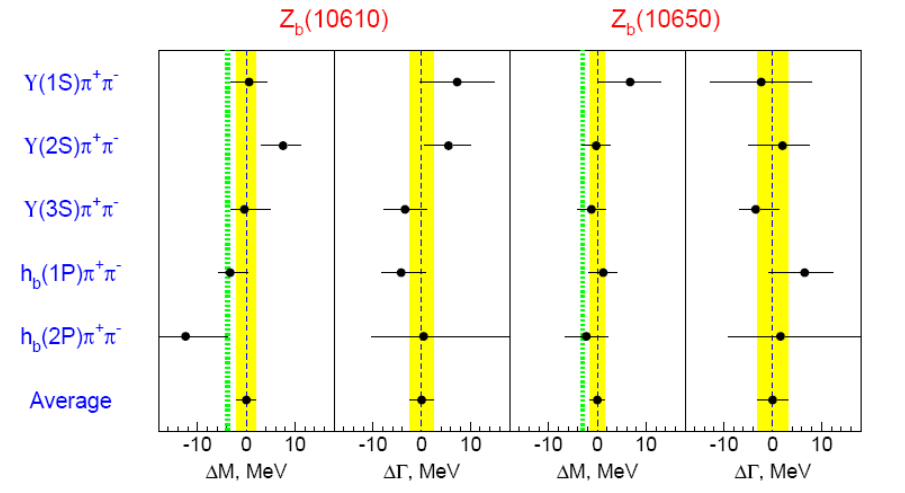
Figure 3. Comparison of Z b (10610) and Z b (10650) parameters obtained from five di ff erent decay channels [22]. The vertical lines consisting of horizontal dashes indicate the B ∗ ¯ B and B ∗ ¯ B ∗ thresholds, respectively. Δ M and ΔΓ denote the deviation of each experiment from the average value of the mass and the width,